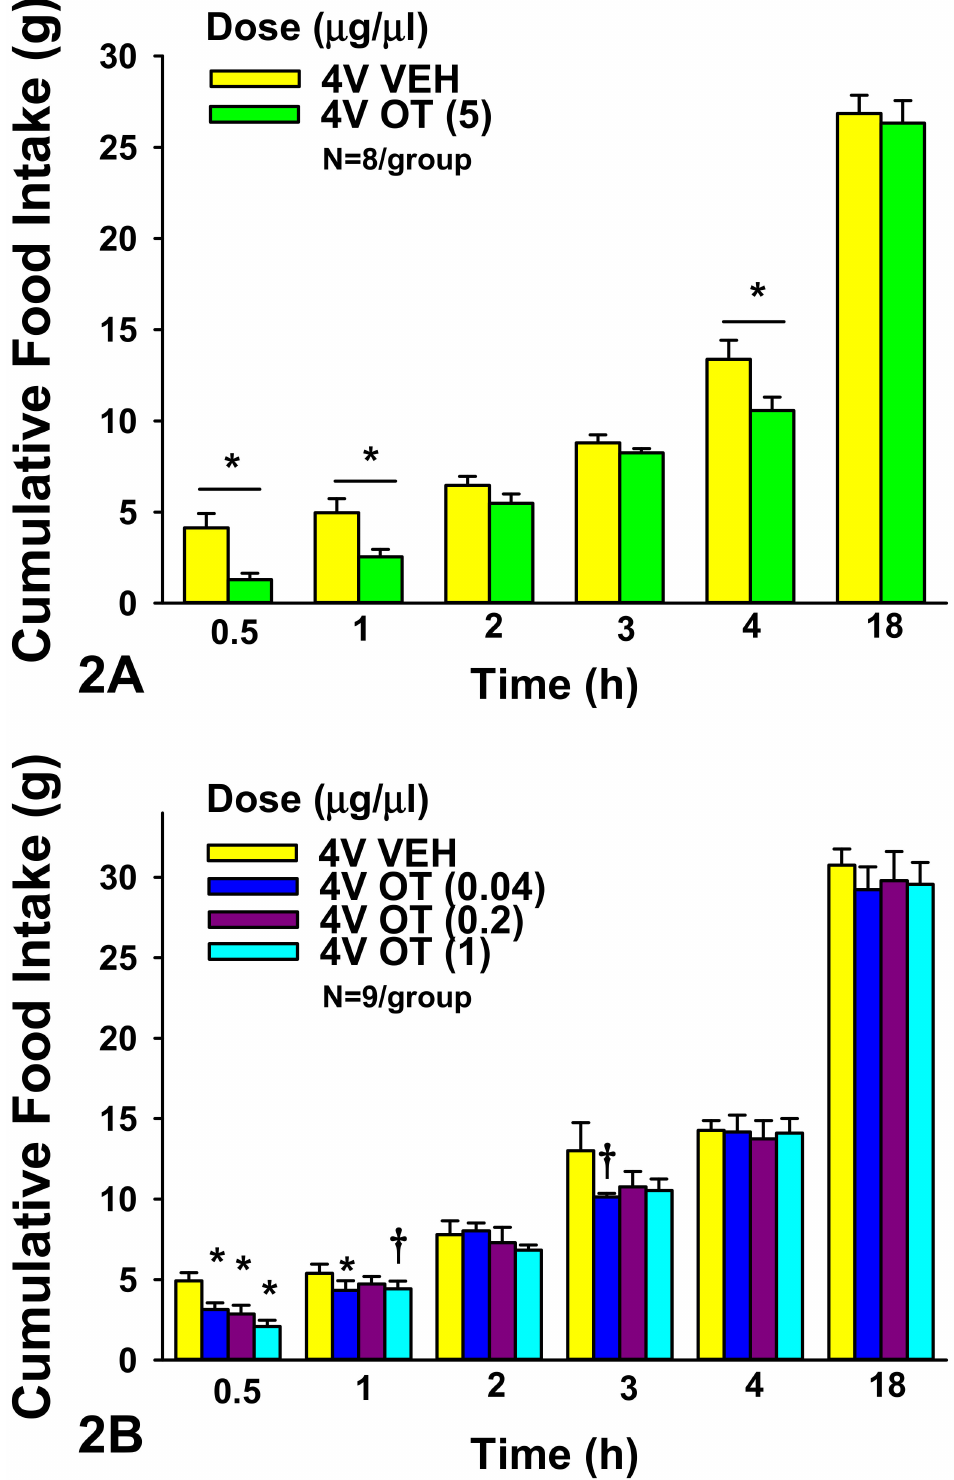
Figure 2. ( A , B ), Effect of acute 4V administration of OT on food intake in male chow-fed SD-SAS rats. ( A ), Food intake was measured in rats that received acute 4V injections of OT (5 µ g/ µ L) or vehicle (N = 8/group). ( B ), Food intake was measured in rats that received acute 4V injections of OT (0.04, 0.2, 1 µ g/ µ L; N = 9/group). Data are expressed as mean ± SEM. * P < 0.05 or † 0.05 < P < 0.1 OT vs.